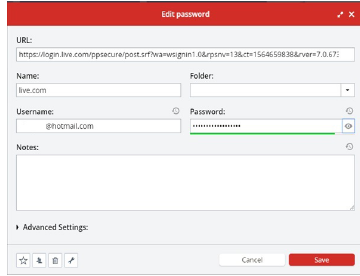
Figure A15. Auto-change password in LastPass does not support all websites, for example, Hotmail. Personal email is hidden.